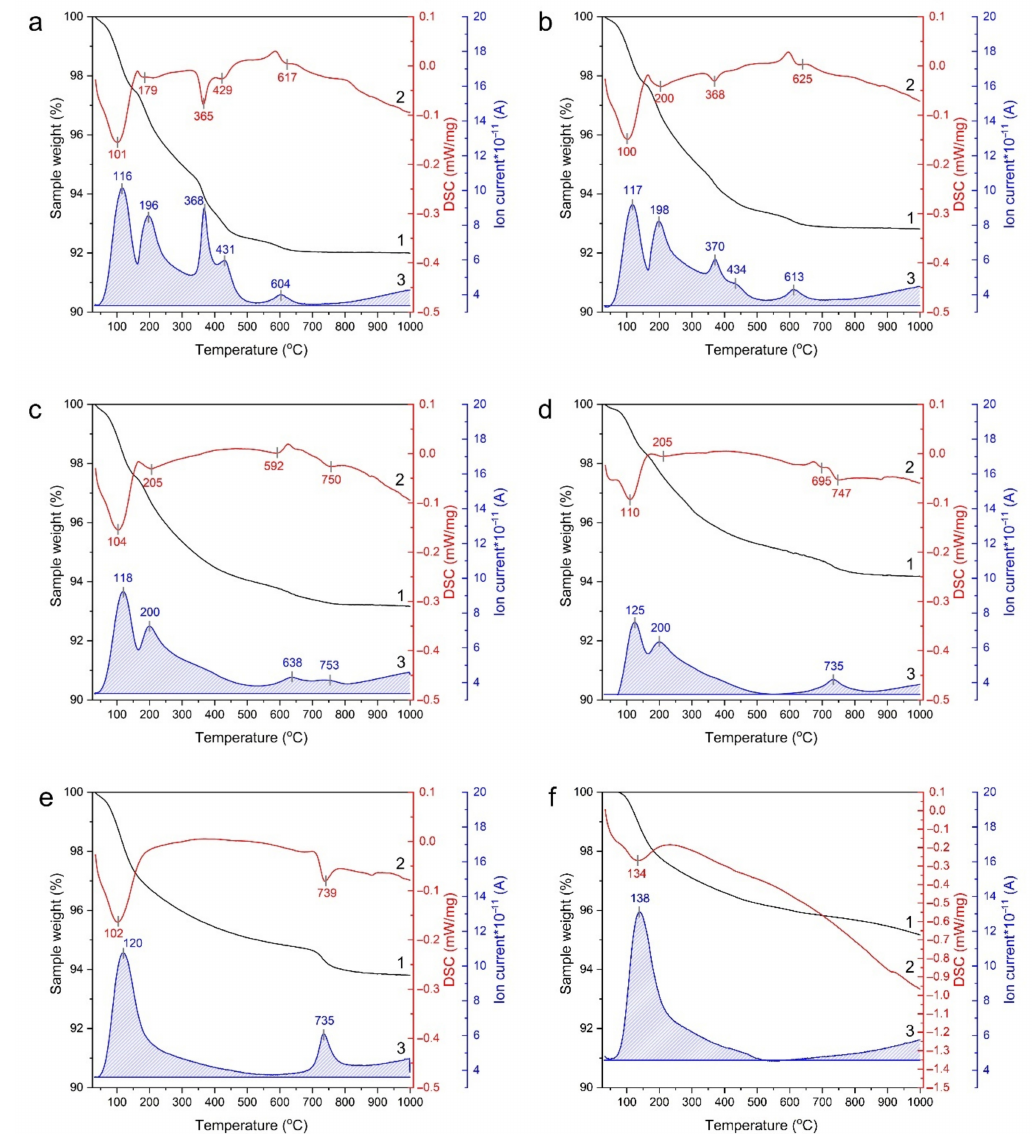
Figure 9. STA of samples with Ca/P ratios 1.21 ( a ), 1.25 ( b ), 1.33 ( c ), 1.42 ( d ), 1.50 ( e ), and 1.67 ( f ). 1: weight loss; 2: DSC; 3: evolution of